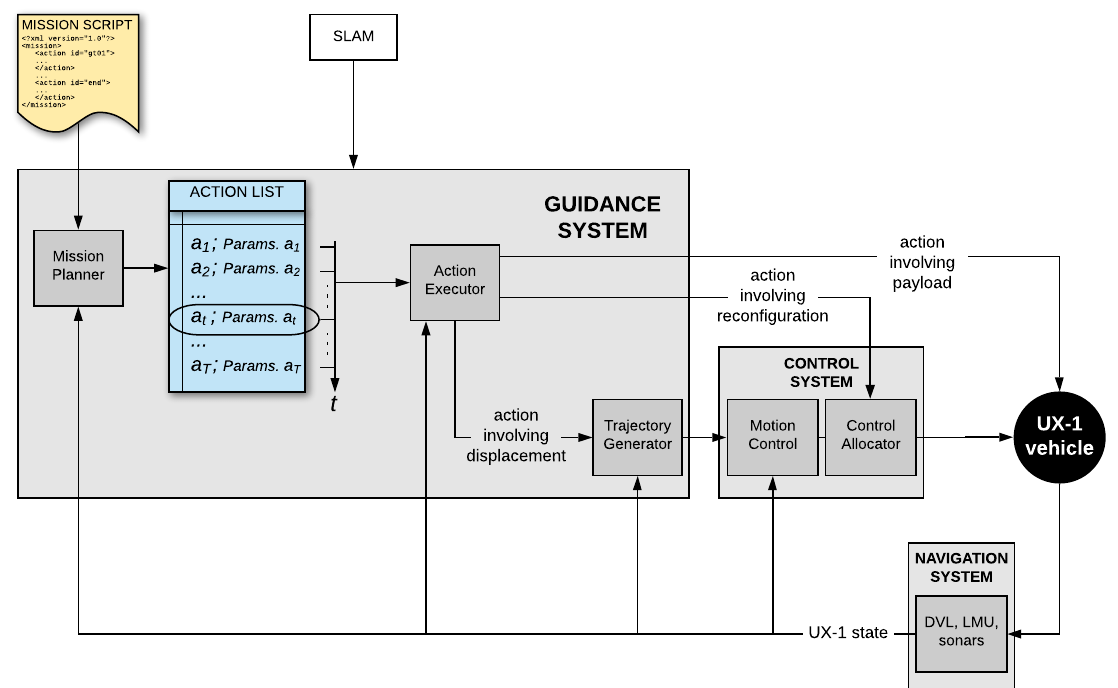
Figure 5. Block diagram of the operation of the Guidance, Navigation, and Control (GNC)